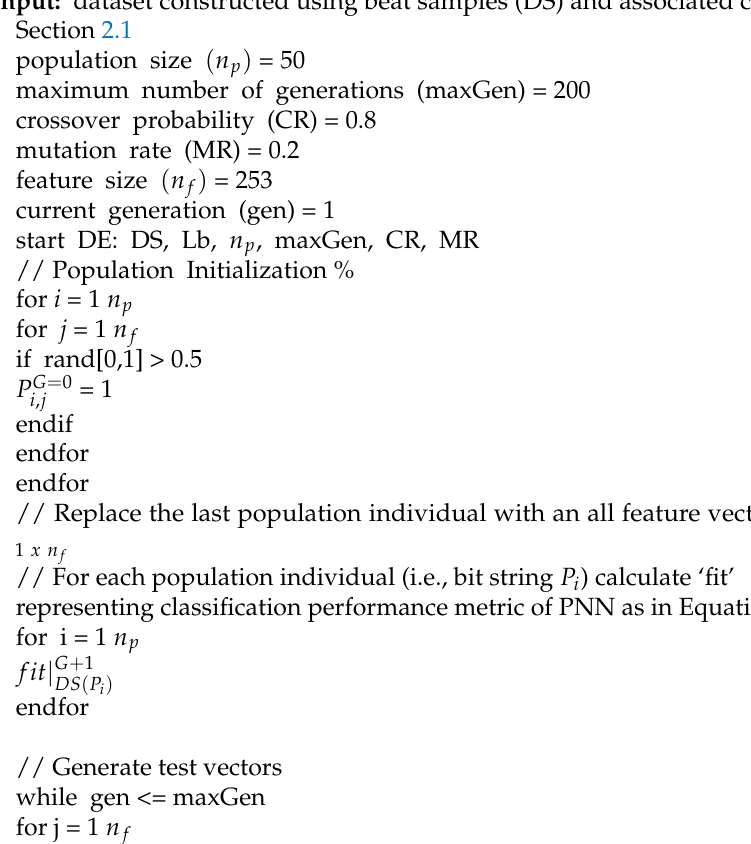
Algorithm 1 Pseudocode of DE-PNN algorithm for feature optimization in heartbeat classification